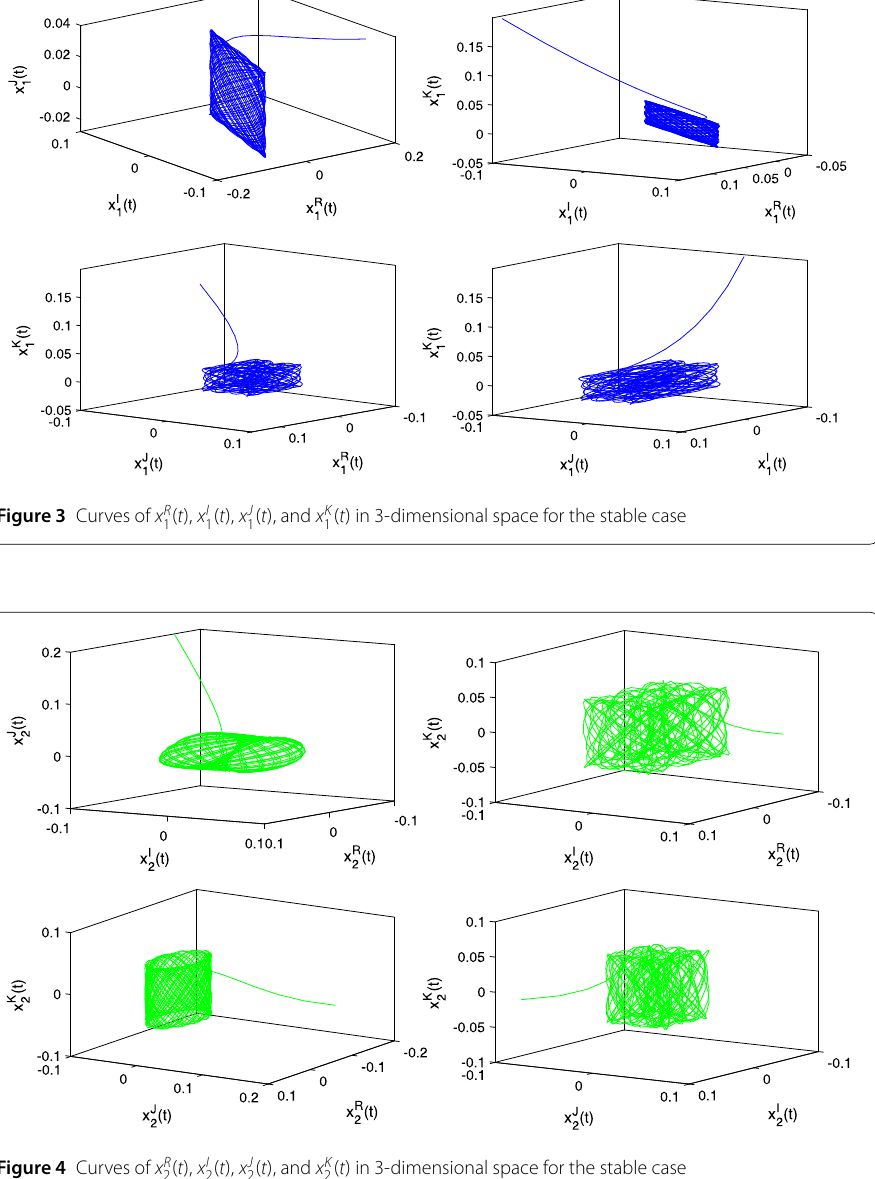
Figure 4 Curves of x R 2 ( t ), x I 2 ( t ), x J 2 ( t ), and x K 2 ( t ) in 3-dimensional space for the stable